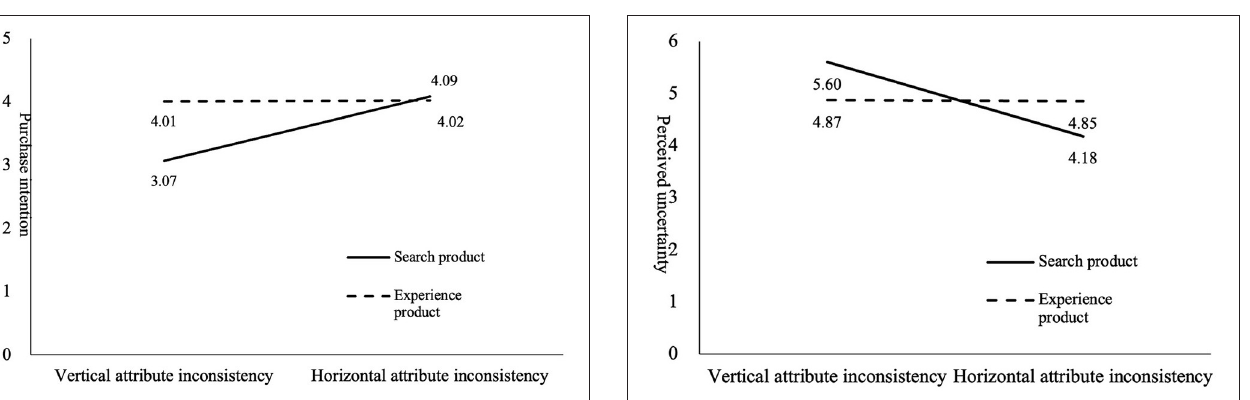
FIGURE 4 | The effect of product type on mediation